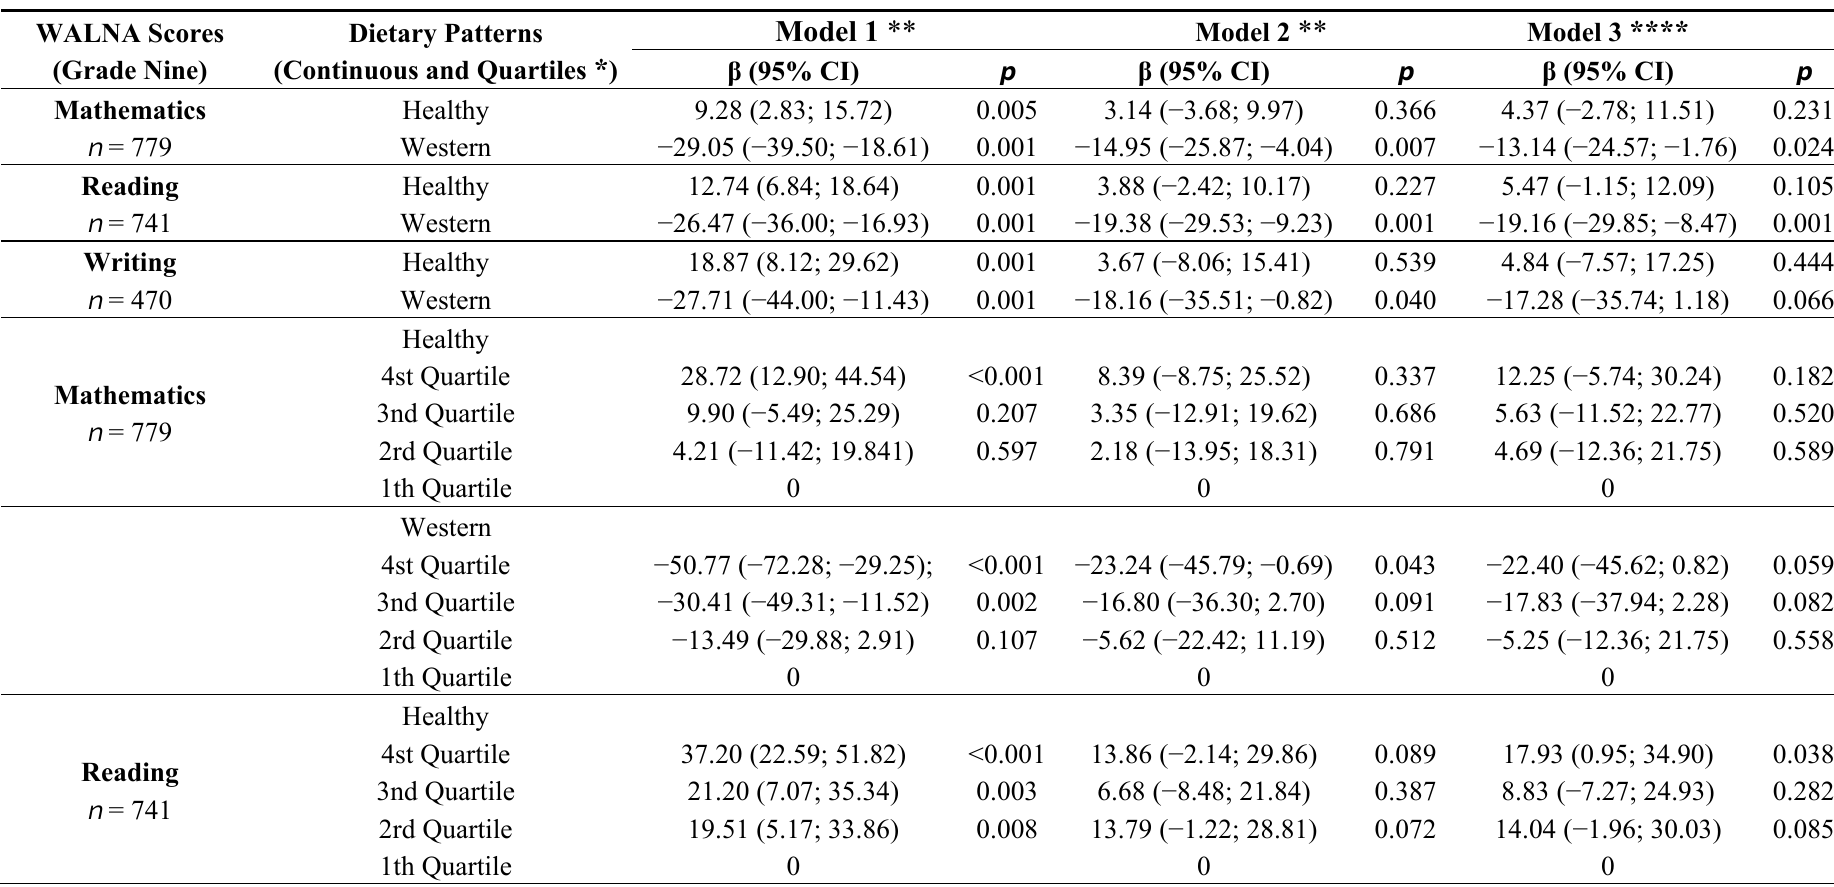
Table 2. Multivariate regression models between WALNA scores at grade nine (age 14) and dietary patterns (both as continuous variables and as quartiles) at age 14 in the Western Australian Pregnancy Cohort (Raine)